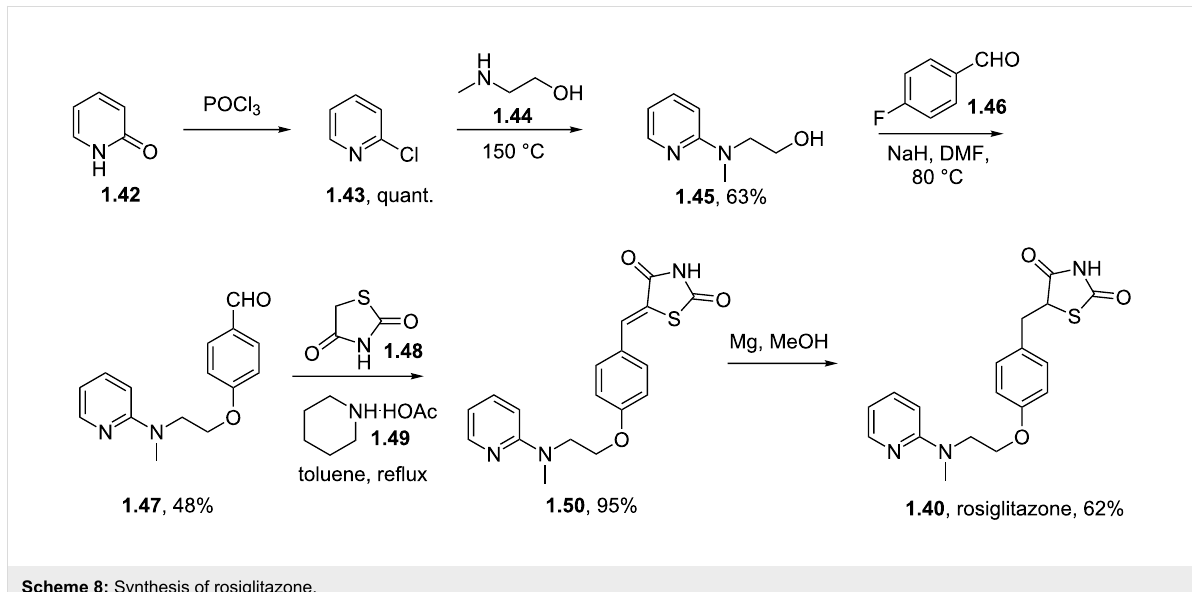
Scheme 8: Synthesis of rosiglitazone.